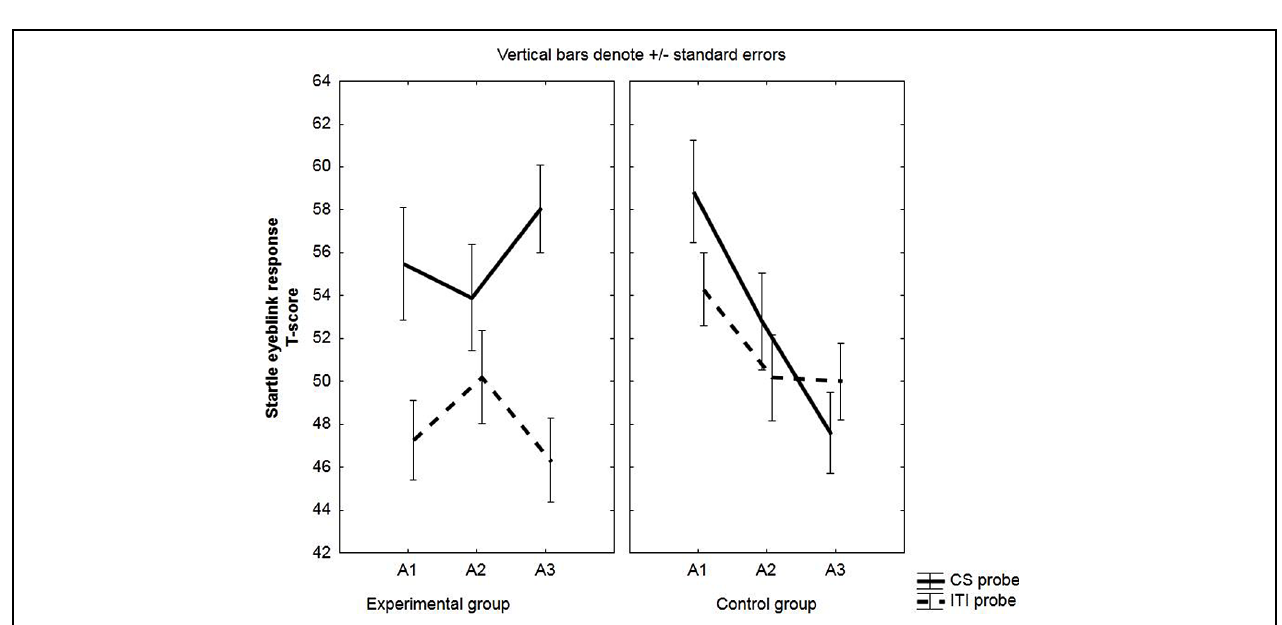
FIGURE 6 | Startle eyeblink responses in unaware participants (EMG). Mean EMG-responses ( T -scores) during the CS and during ITI for the experimental and the control group. Startle eyeblink responses were averaged across two acquisition trials (A1, A2, A3).